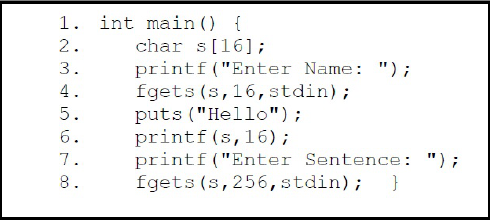
Figure 31. Vulnerable C